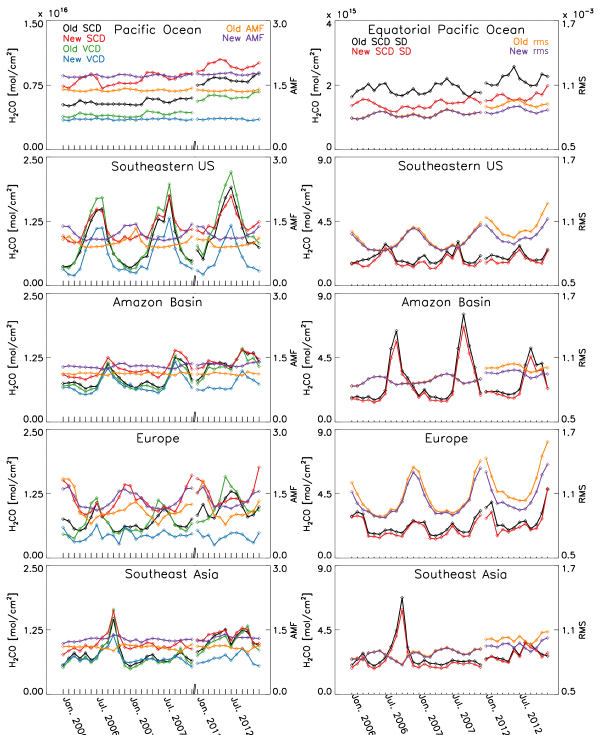
Figure 10. Year 2006, 2007, and 2012 monthly average of the 0.2 ◦ × 0.2 ◦ gridded SCDs, VCDs (only reference sector corrected for the new retrieval), AMFs, rms’s, and gridded SCD standard de- viation time series for the regions depicted in Fig. 5 plus a sixth re- gion named equatorial Pacific Ocean including the latitudes inside region A between − 20 ◦ S and 20 ◦ N added to study the evolution of the standard deviation of the gridded SCDs in a remote region. The break in the x axis indicates the transition from 2007 to 2012.